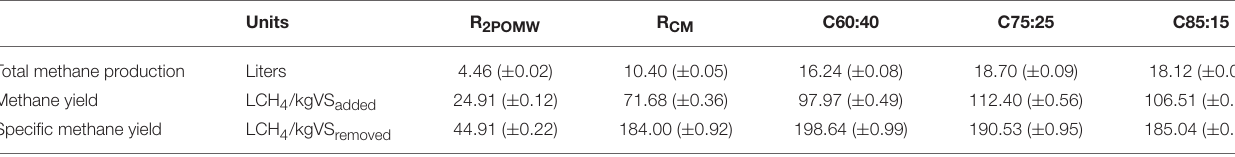
TABLE 4 | Methane production, methane yield and specific methane yield of the 2POMW, CM and different co-digestion